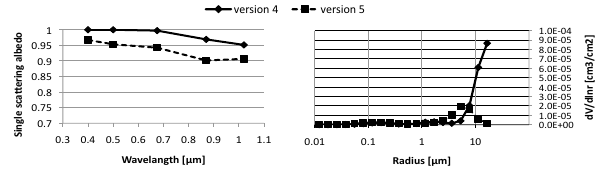
Fig. 11. SSA (left panel) and SDF (right panel) at Pune retrieved by version 4 (solid line) and by version 5 (dashed line) for a cirrus case (23 October 2008, 08:36:00.2 to 08:49:28.9UTC).